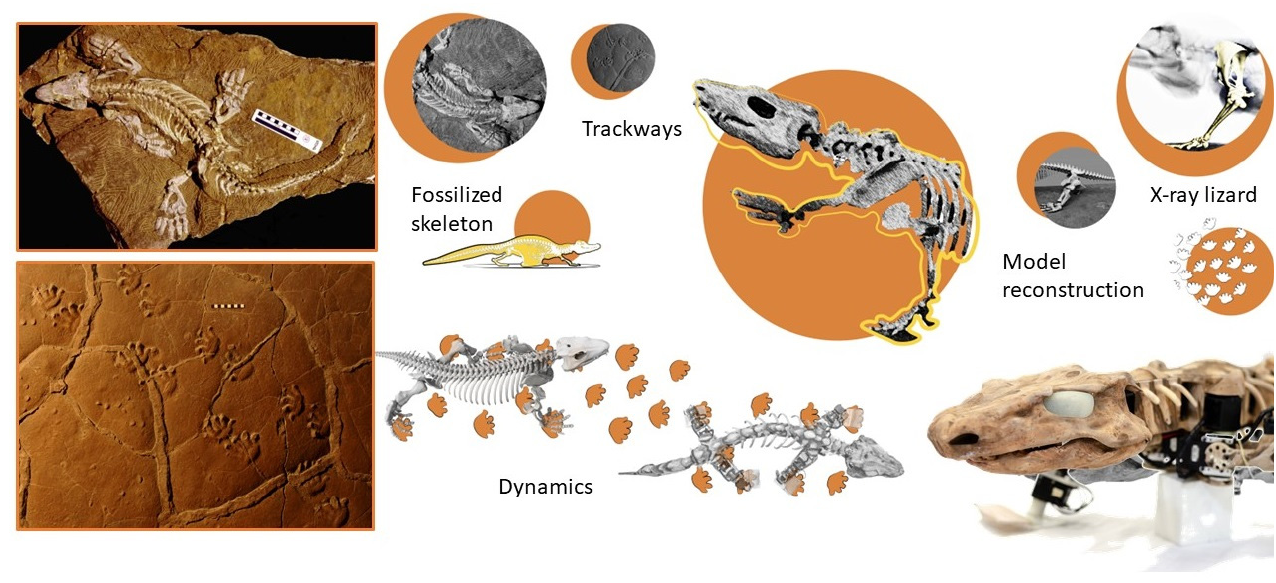
Figure 5. OroBOT, a moving robot model of the Orobates pabsti stem amniote based on CT scans of its skeletal remains and trackways. Image courtesy of Thomas Martens, Museum der Natur Gotha;